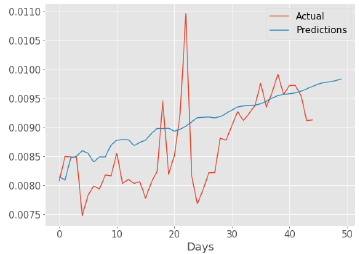
Figure 8. Actual vs Predicted fouling values